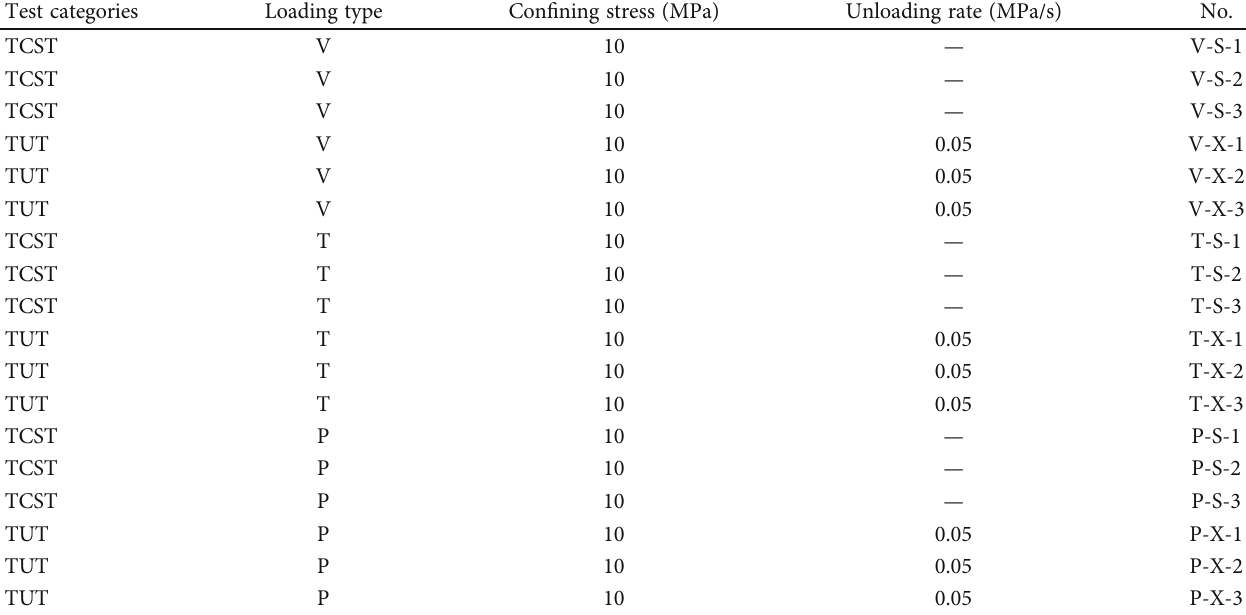
Table 1: Experimental